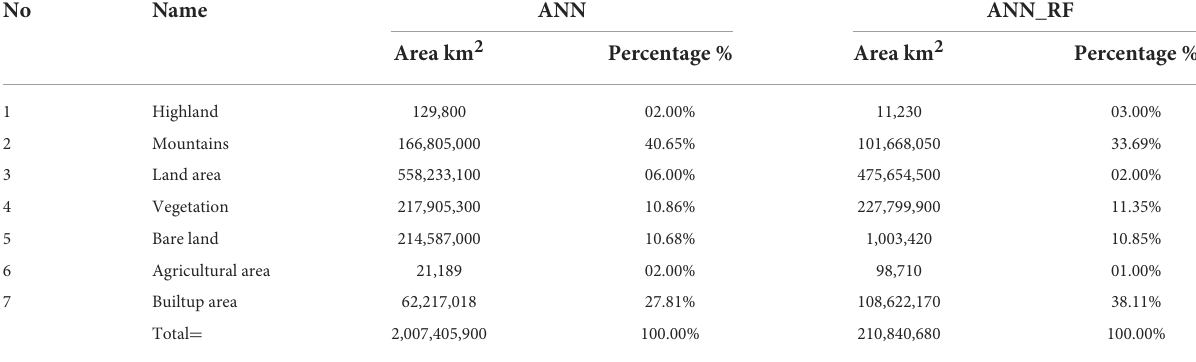
TABLE 5 Area and percentages LULC for ANN and (ANN_RF) to Landsat-8 satellite.